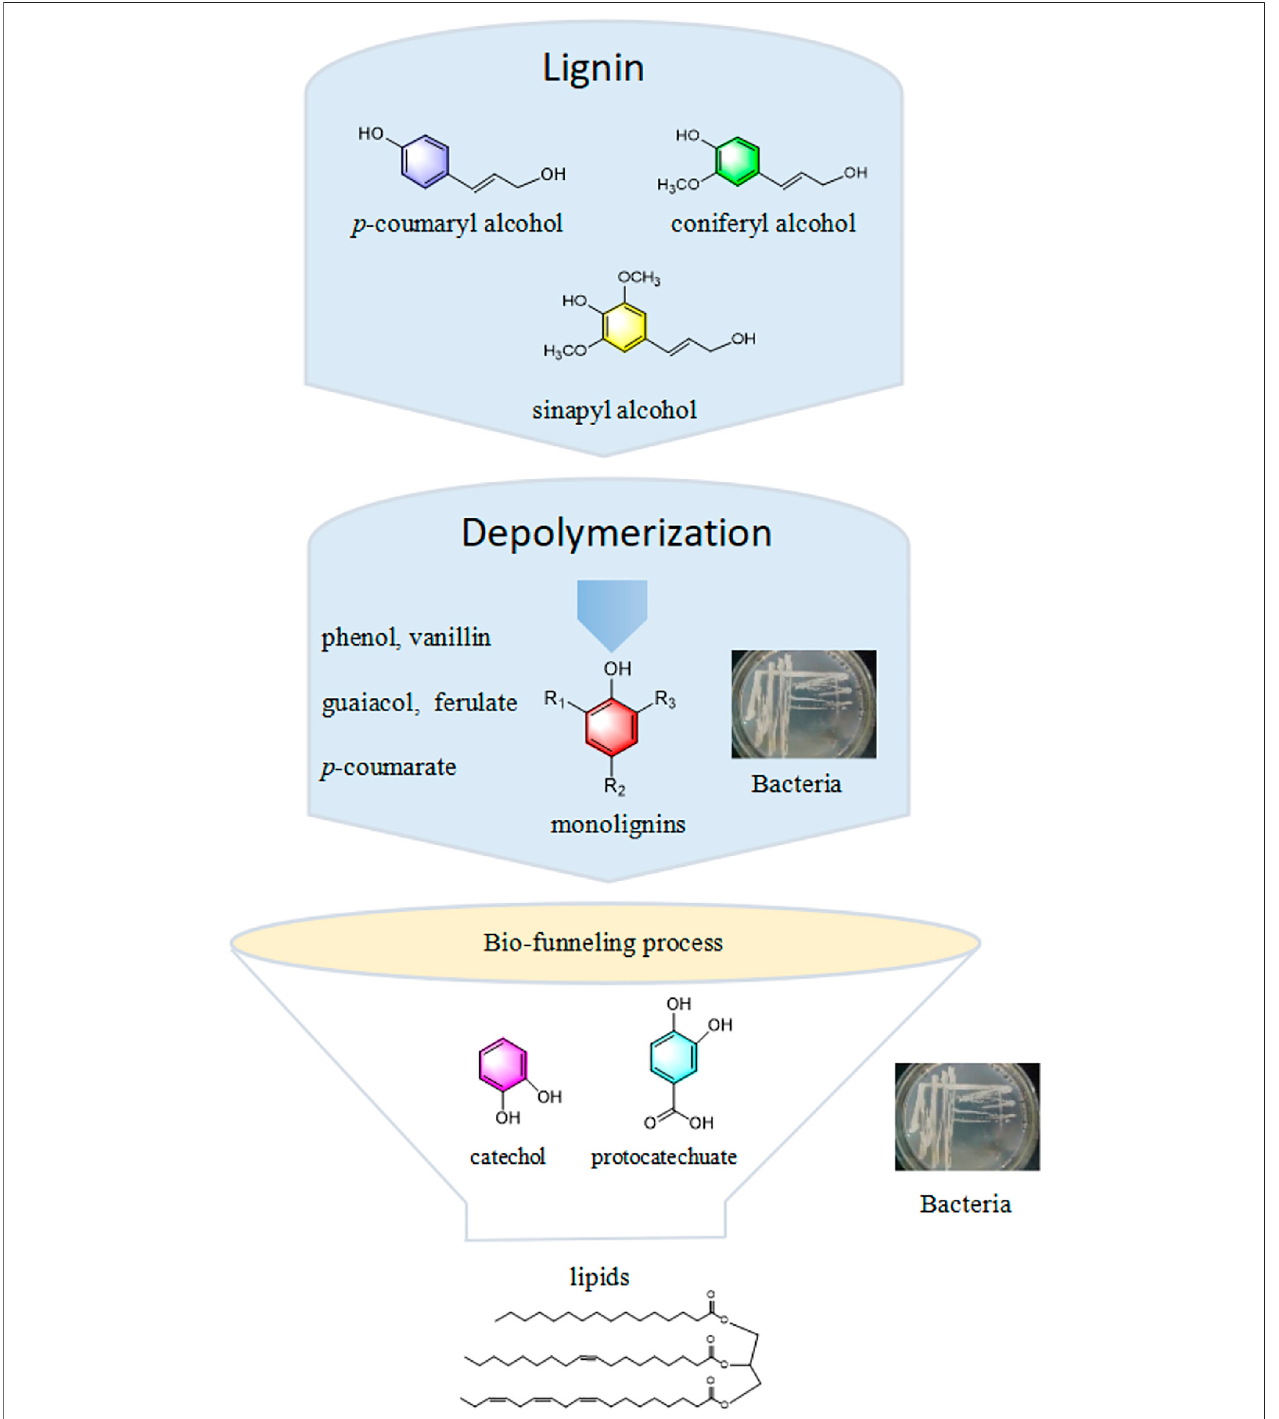
FIGURE 1 | The scheme of lipids production from lignin through a bio-funneling process.